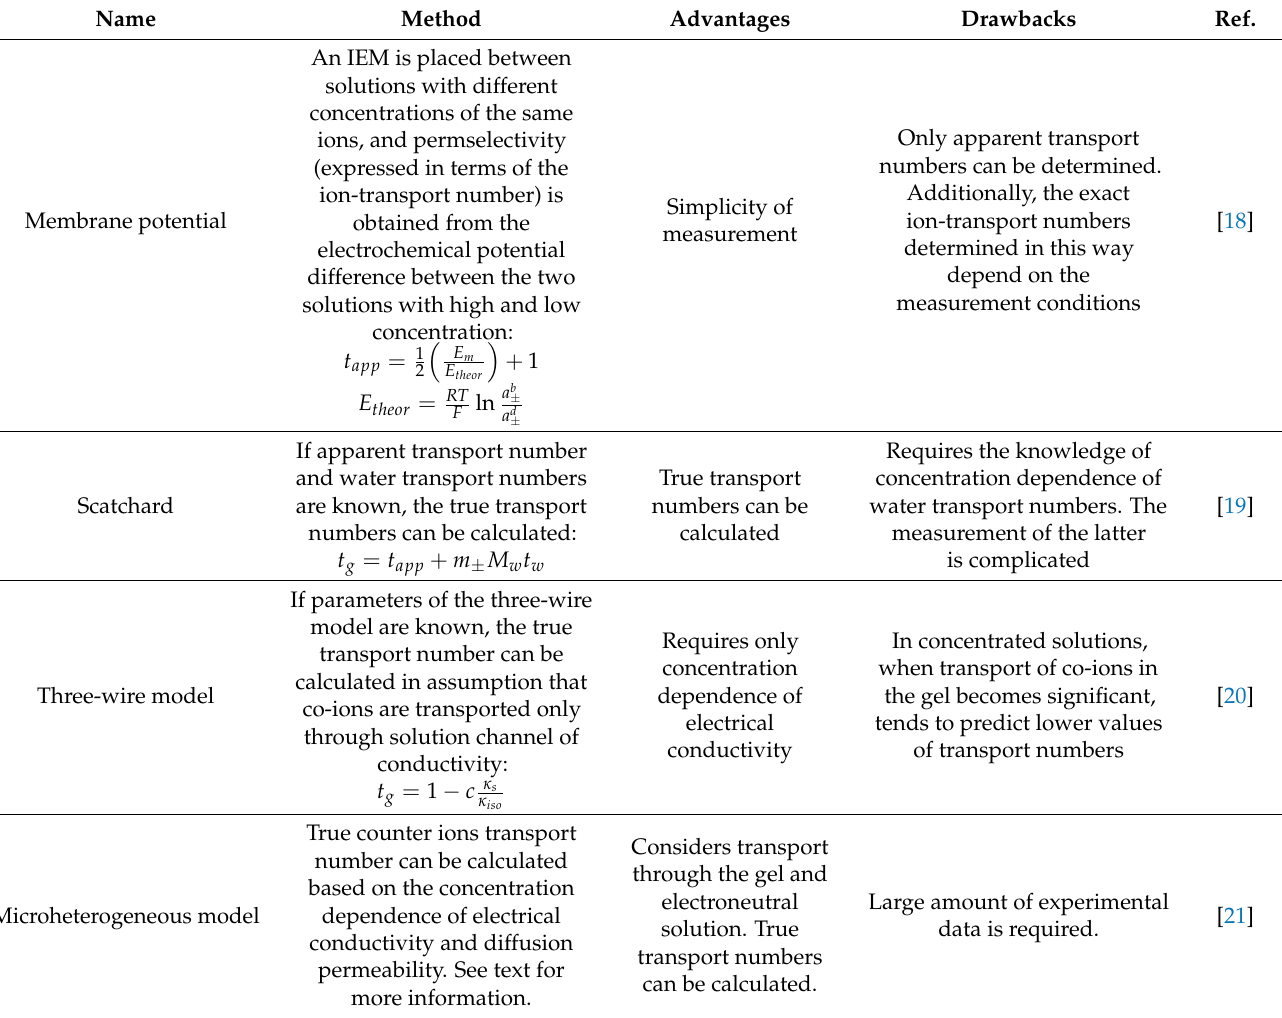
Table 1. Methods used for transport numbers’